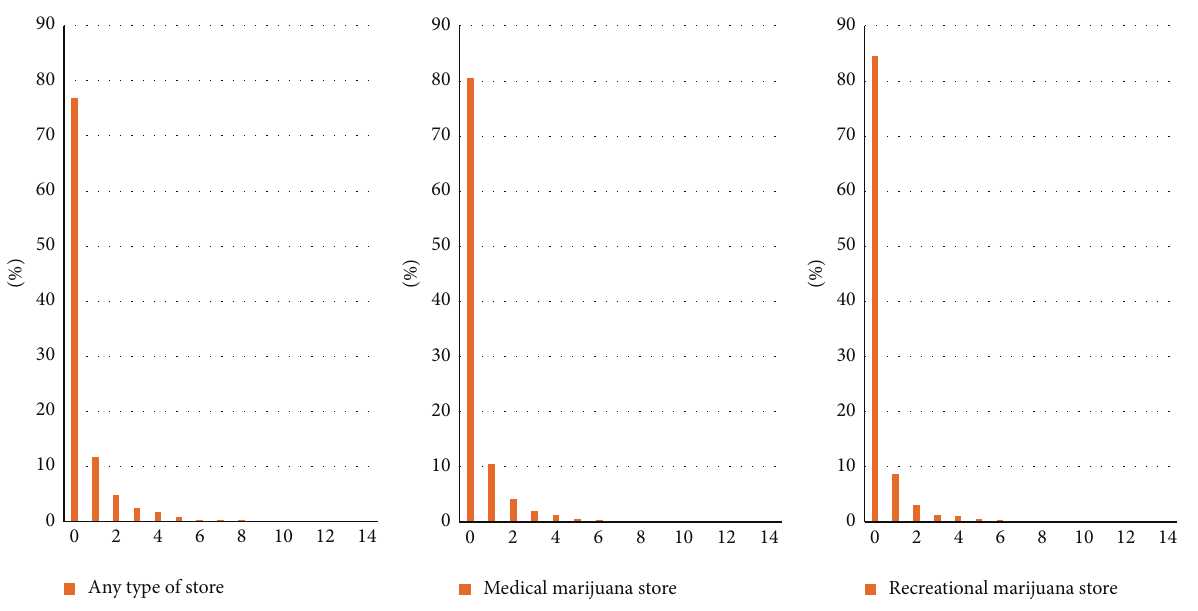
Figure 2: Density of marijuana stores at census tract level in Colorado (census tract 𝑁 = 1 ,249). Table 2: Availability of marijuana stores within various buffers around schools in Colorado (schools 𝑁 = 2